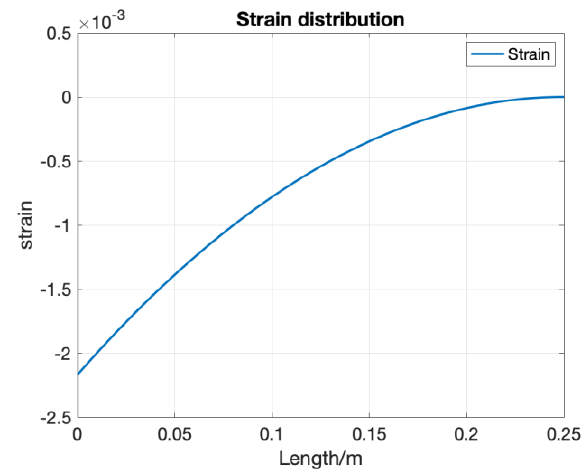
Figure 14. Strain distribution when structure is under uniform distributed loading.